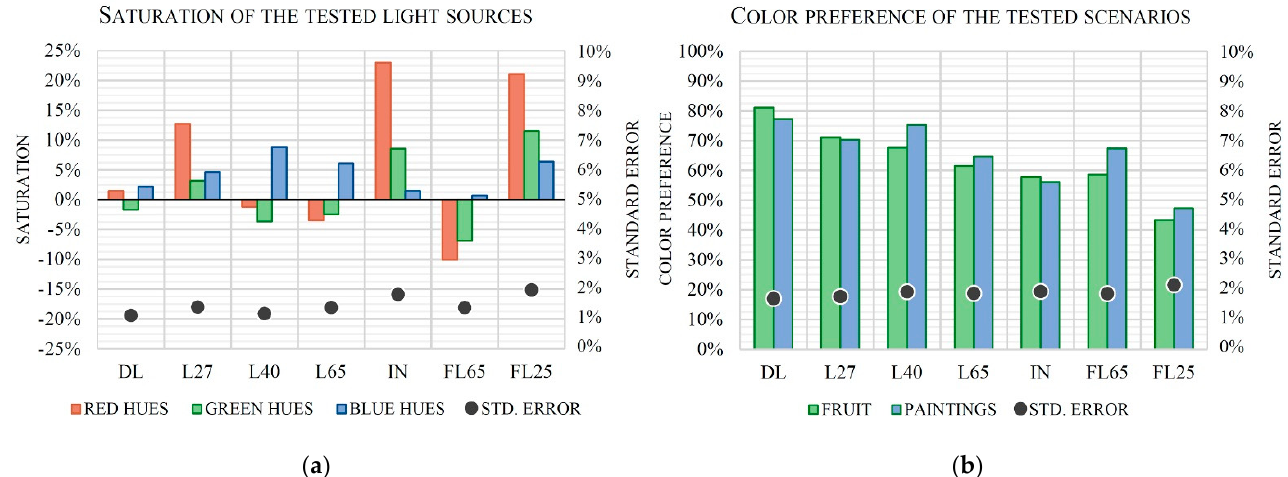
Figure 8. ( a ) Left: Perceived saturation provided by the tested light sources of the set of color samples. ( b ) Right: Color preference of the tested scenarios: set of fruits and paintings.